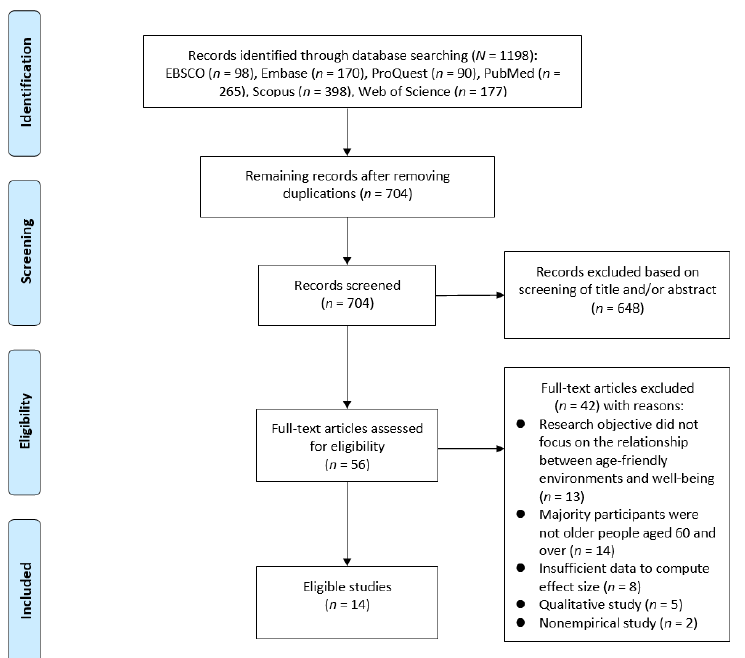
Figure 1. Flow chart of the selection process of meta-analysis.